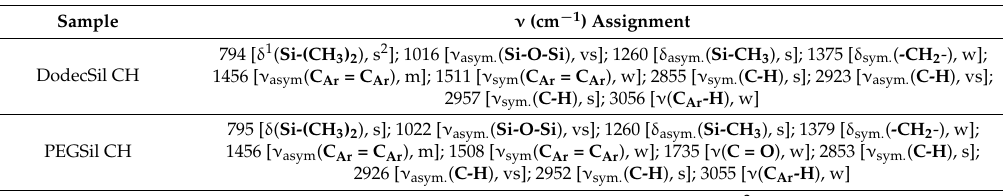
Table 2. Assignments of the main Fourier-transform infrared spectroscopy with attenuated total reflectance (FTIR-Atr) features of DodecSil CH and PEGSil CH.